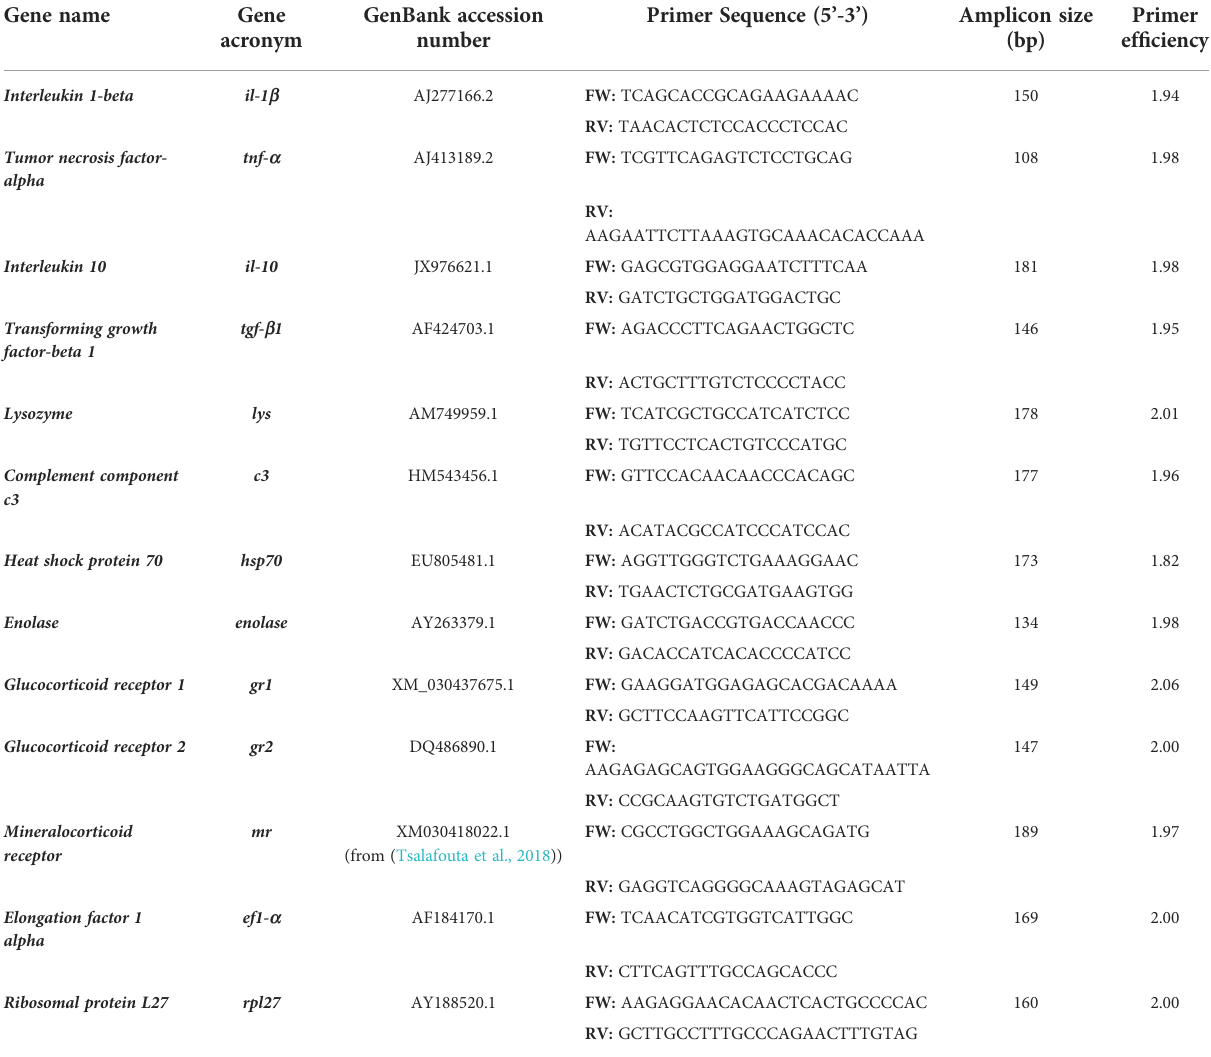
TABLE 1 List of primers for RT-qPCR